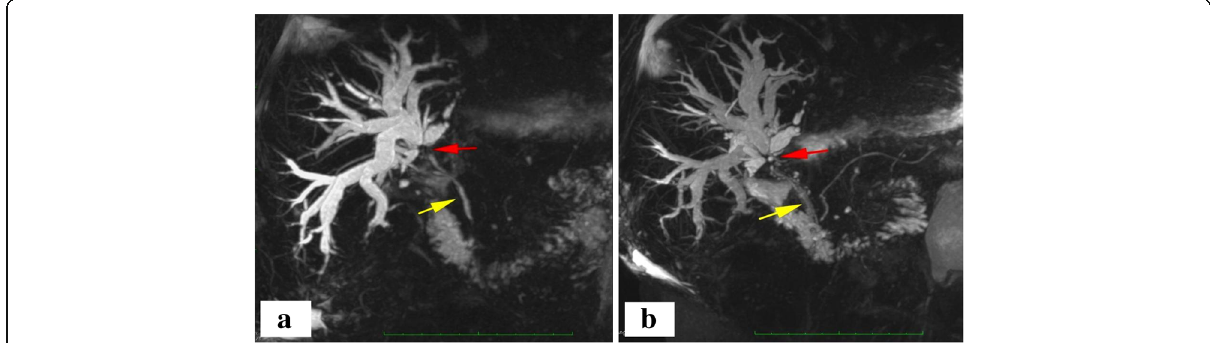
Fig. 6 A 59-year-old male 8 months after liver transplantation with duct-to-duct anastomosis. MRCP 3D MIP reconstructed coronal images showed the presence of severe anastomotic biliary stricture (red arrow) with normal CBD caliber (yellow arrow) ( a ), managed by CBD stent insertion by ERCP with still persistent stricture with severe intrahepatic biliary dilatation ( b ) due to slipped